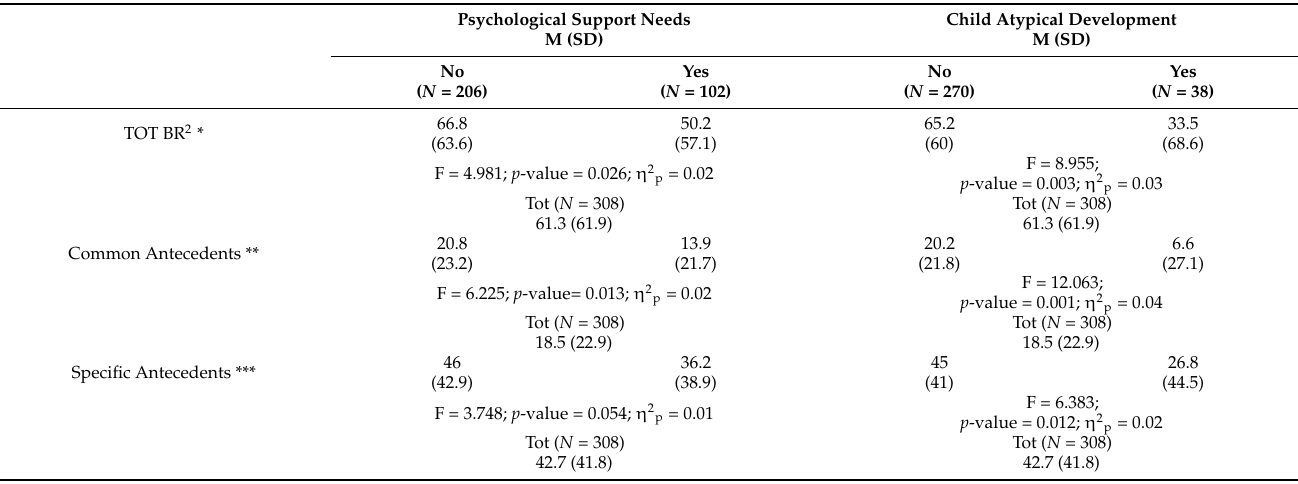
Table 1. Parental distress descriptive data and ANOVA analyses for parental psychological support needs and the presence of a child exhibiting atypical patterns of development.